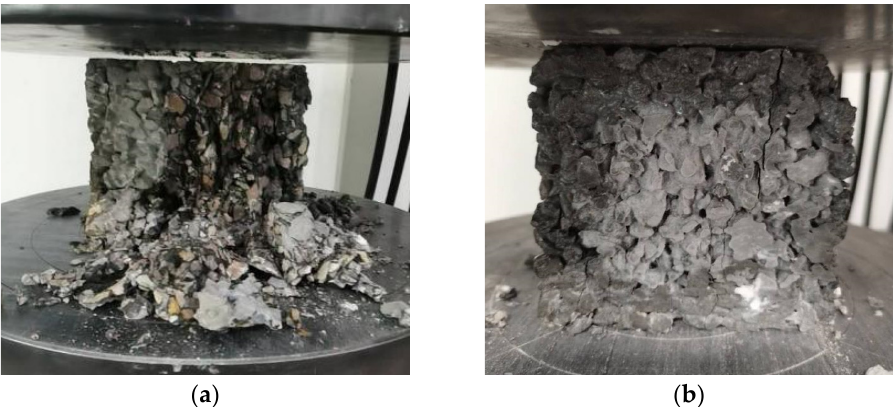
Figure 2. The failure patterns of ( a ) cubic specimens without basalt fiber and ( b ) cubic specimens with basalt fiber.